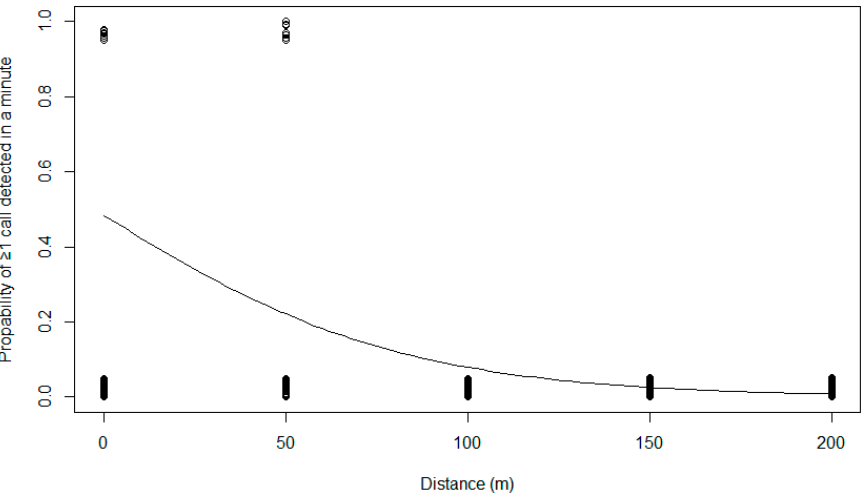
Figure 6. Fitted logistic regression of probability of at least one of ten cow (lowing) calls in a minute of acoustic data being detected using the cow detection algorithm, plotted as a function of the acoustic sensor’s distance to the calling